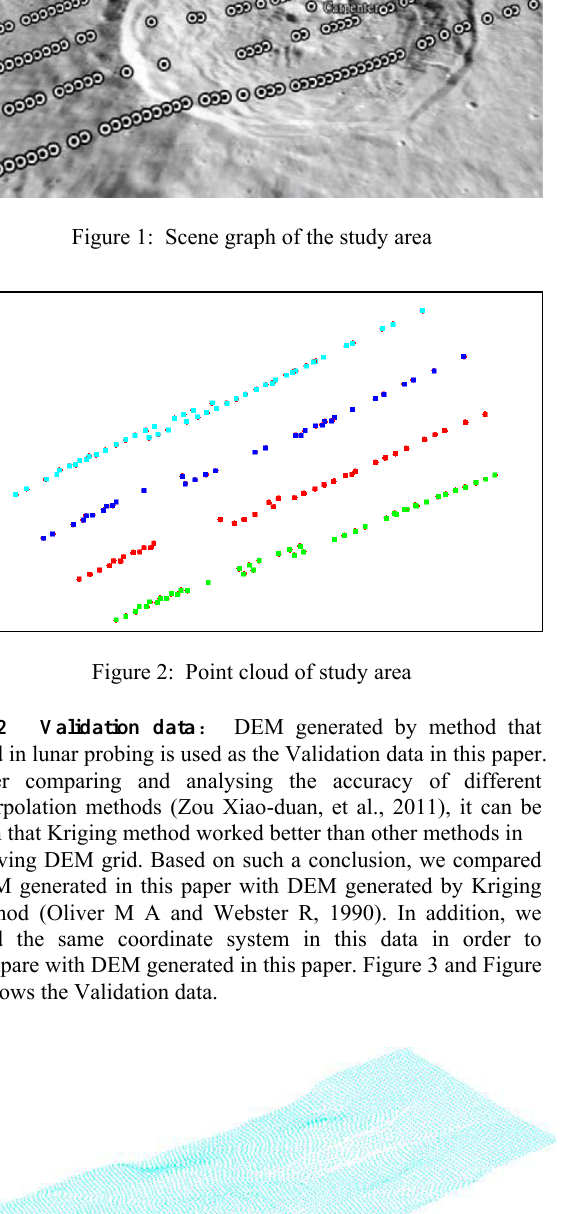
Figure 3: Point cloud that generated by Kriging method